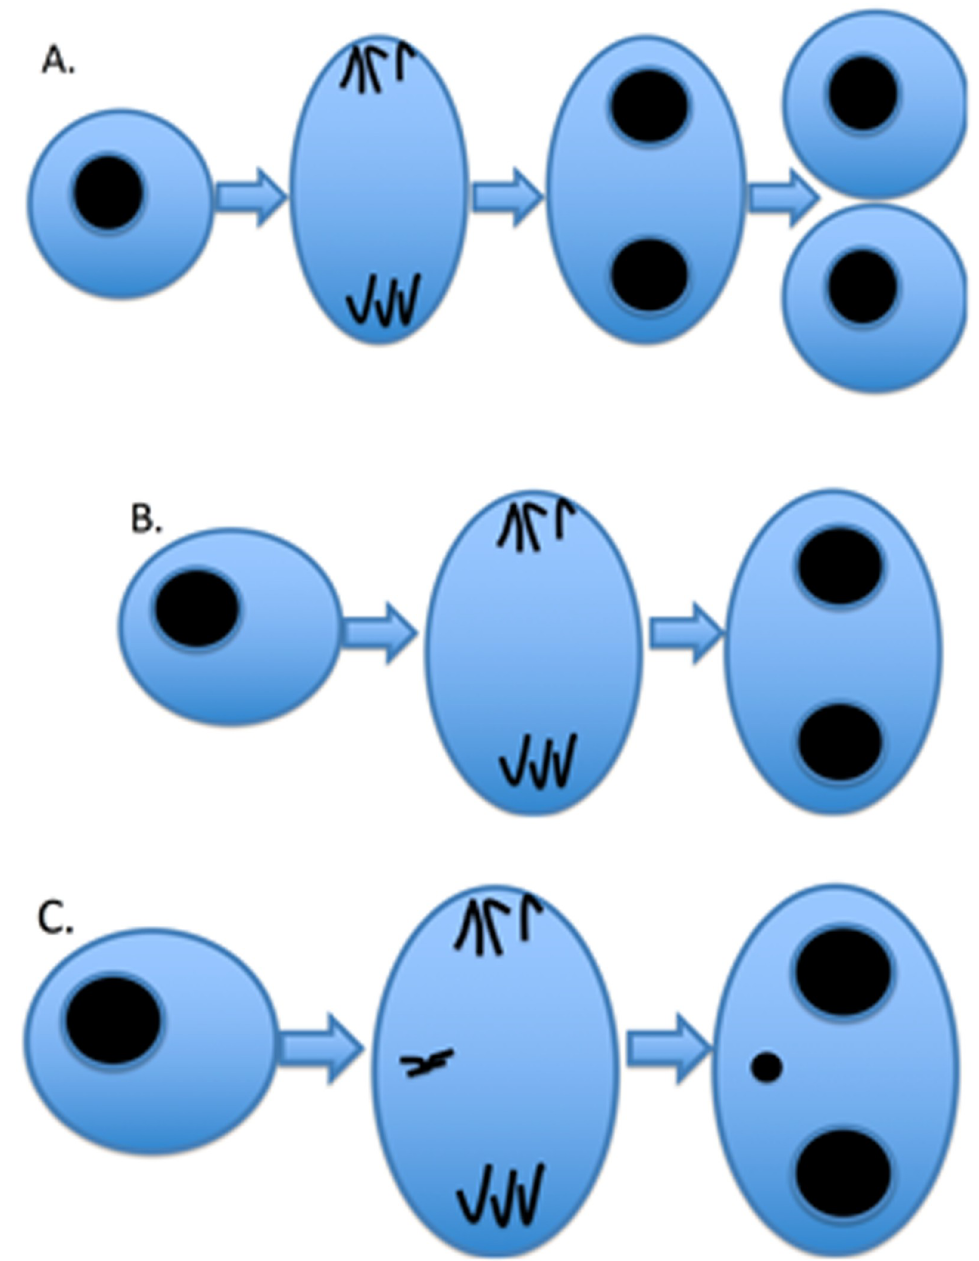
Fig 1. CBMN/Cytome assay. A: Typical process of cell division. B: Application of cytochalasin-B prevents cytokinesis to give rise to binucleated cells. C: Cell treated with cytochalasin-B that contains a whole chromosome lagging behind that does not attach to the mitotic spindle. The small extranuclear body in the binucleated cell is a MN.